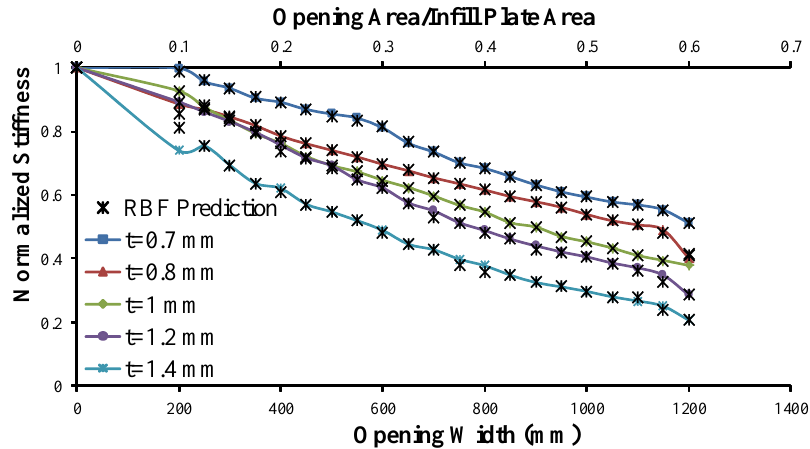
Figure 11. Real and predicted normalized stiffness values versus the various A o /A s